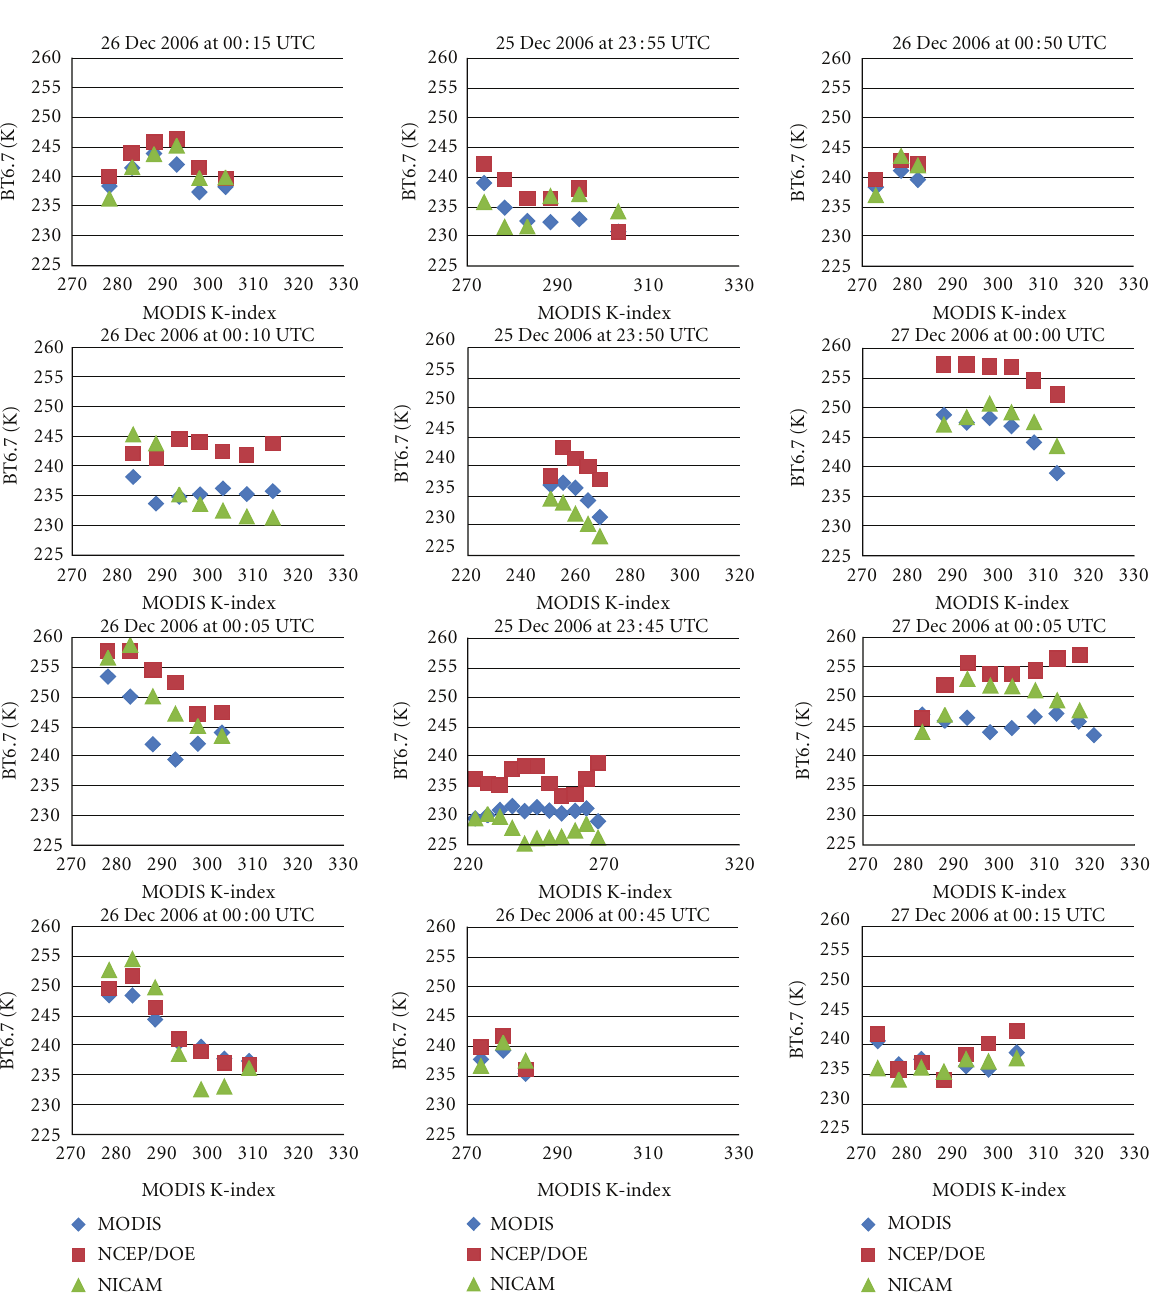
e ff ect: for example, the deseasonalized UTBT observations of Dec 2006 are higher by around 1.5 K than the